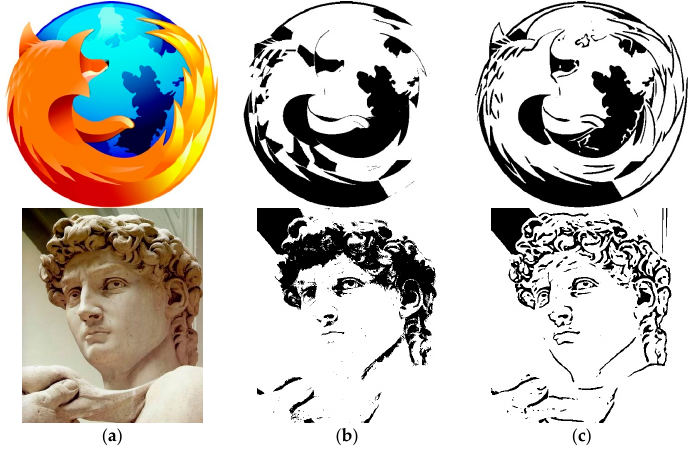
J. Imaging 2017 , 3 , 16